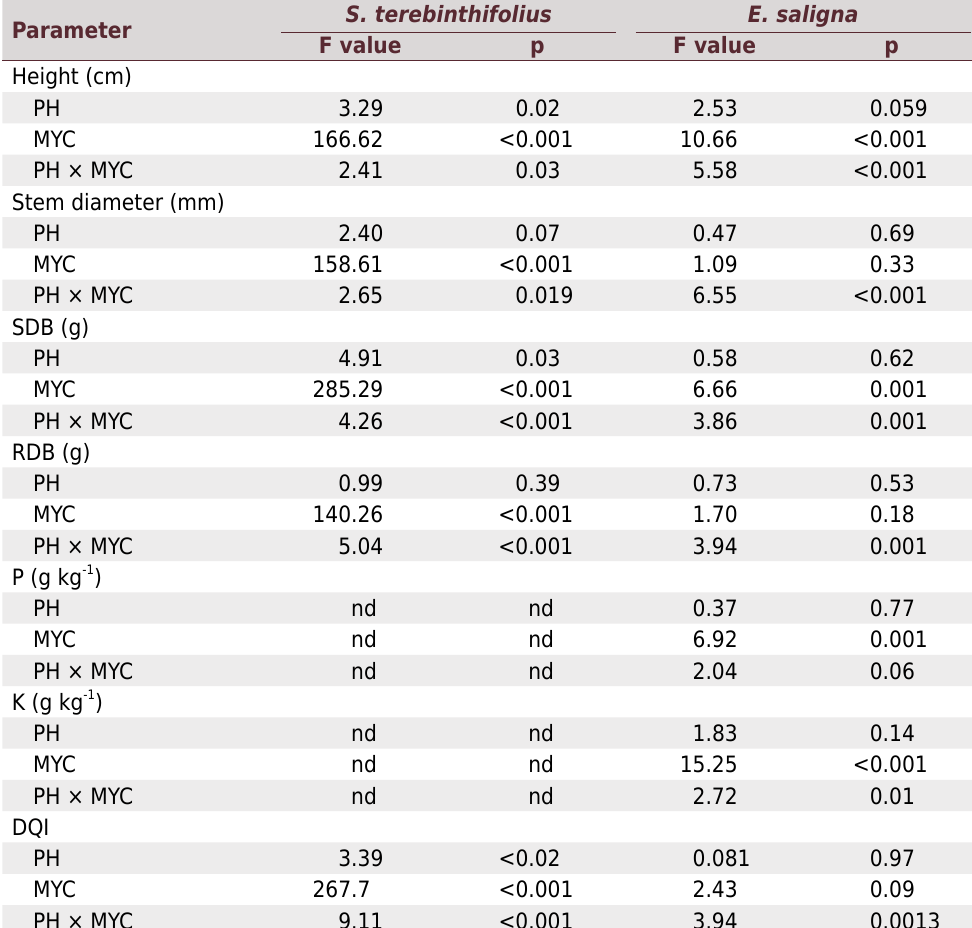
Table 1. Summary of two-way analysis of variance of height, stem diameter, shoot (SDB) and root (RDB) dry biomass, shoot phosphorus (P), shoot potassium (K), and the Dickson Quality Index (DQI) for seedlings of Schinus terebinthifolius and Eucalyptus saligna with phonolite (PH) and mycorrhizal inoculum (MYC) as independent factors